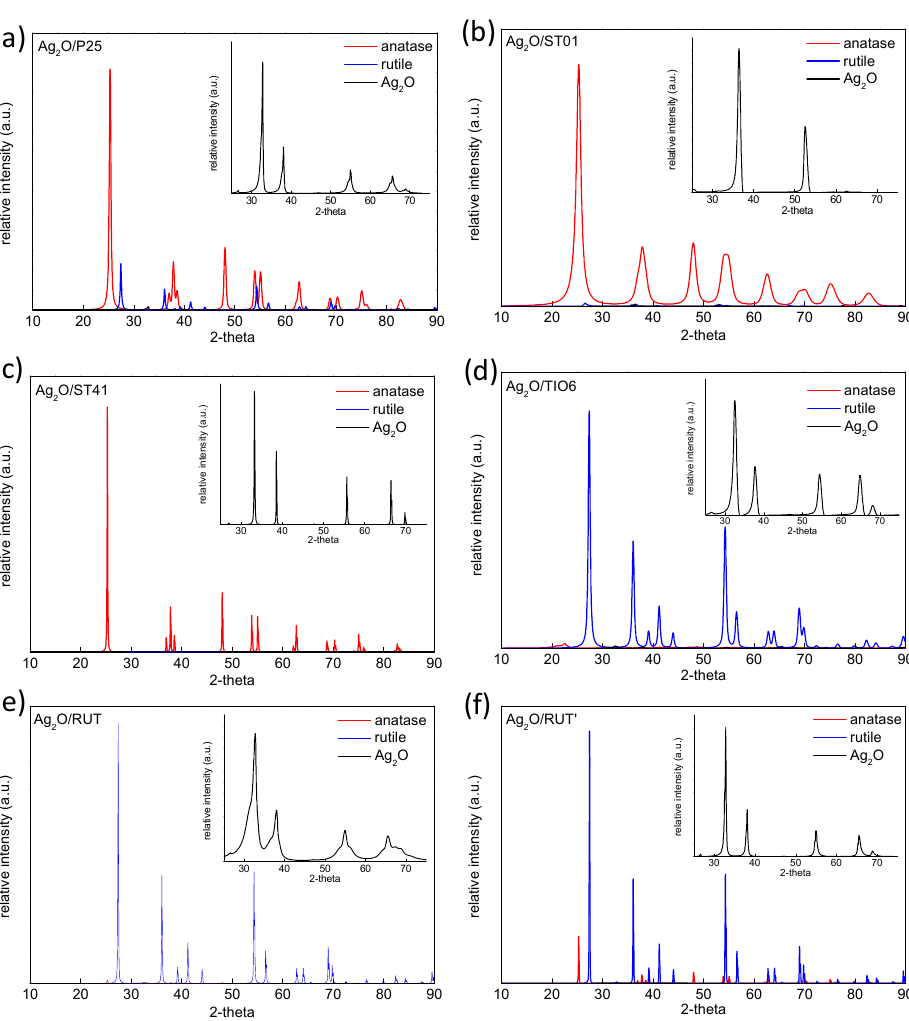
Figure 2. XRD diffractograms of Ag 2 O/TiO 2 samples: ( a ) Ag 2 O/P25, ( b ) Ag 2 O/ST01, ( c ) Ag 2 O/ST41, ( d ) Ag 2 O/TIO6, ( e ) Ag 2 O/RUT, ( f ) Ag 2 O/RUT’. (Insets) XRD patterns of Ag 2 O (after subtraction of titania peaks).